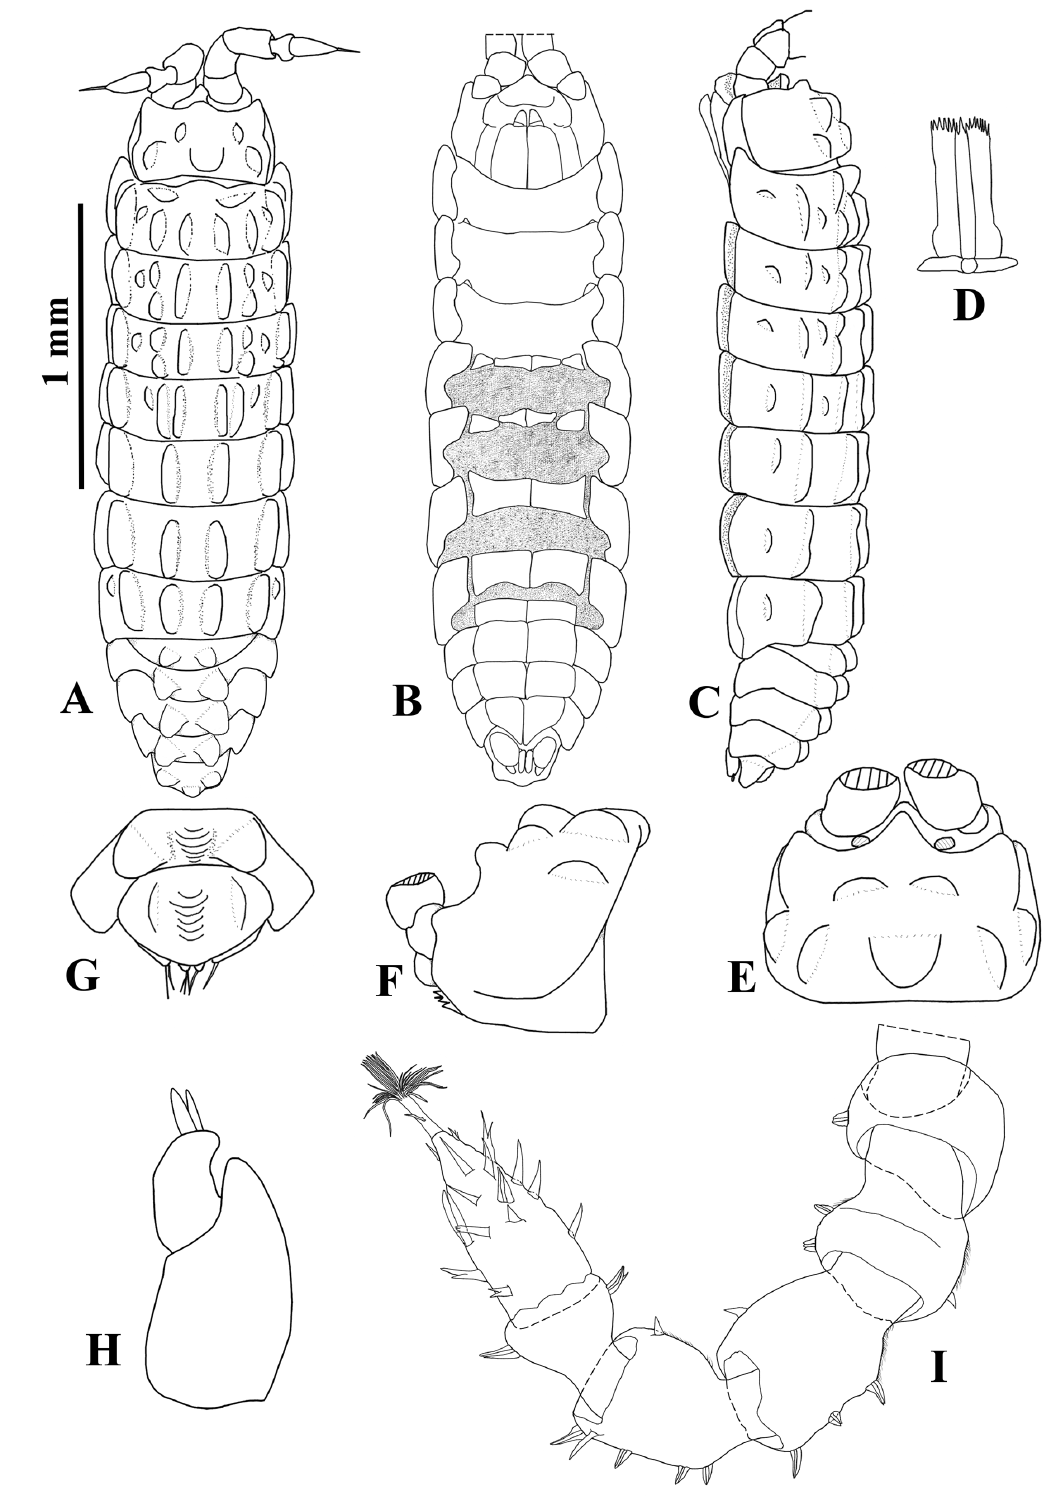
Fig. 6. Stenoniscus nestori López-Orozco, Taiti & Campos-Filho sp. nov., paratype, ♂ (CDUC- CRU 186). A . Habitus, dorsal view. B . Habitus, ventral view. C . Habitus, lateral view. D . Dorsal scale-seta. E . Cephalon, dorsal view. F . Cephalon, lateral view. G . Pleonite 5 and telson, dorsal view. H . Antennula. I .